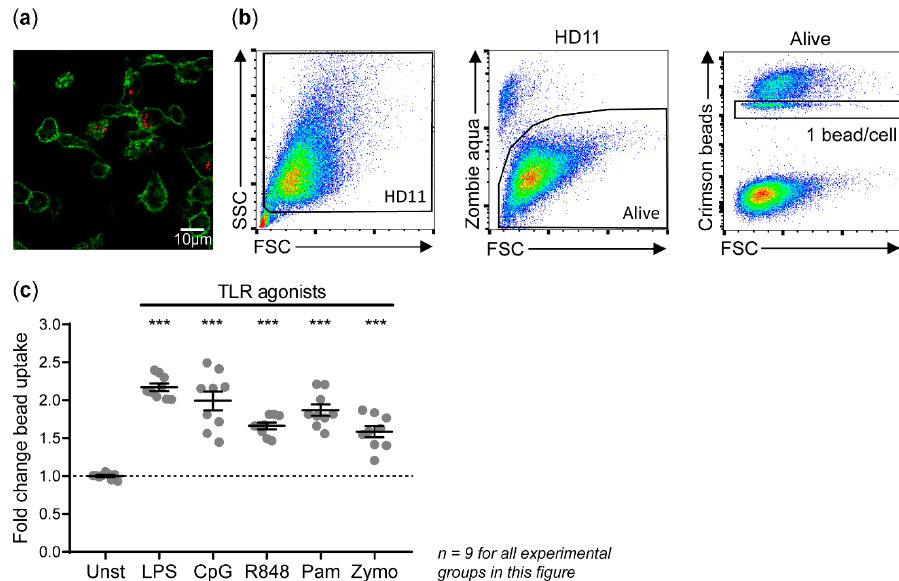
Figure 2. TLR agonists stimulated the uptake of IgY-opsonized beads by HD11 cells. ( a ) Confocal microscopy confirmed the uptake of IgY-opsonized beads by HD11 cells. The surface of unstimulated HD11 cells was made visible by WGA-Alexa Fluor 488 shown in green and IgY-opsonized beads are shown in red. A corresponding video showing the 3-D model of this composition can be found in Supplementary Materials Video S1. ( b ) Bead uptake by HD11 cells was quantified by flow cytometry. HD11 cells were gated for